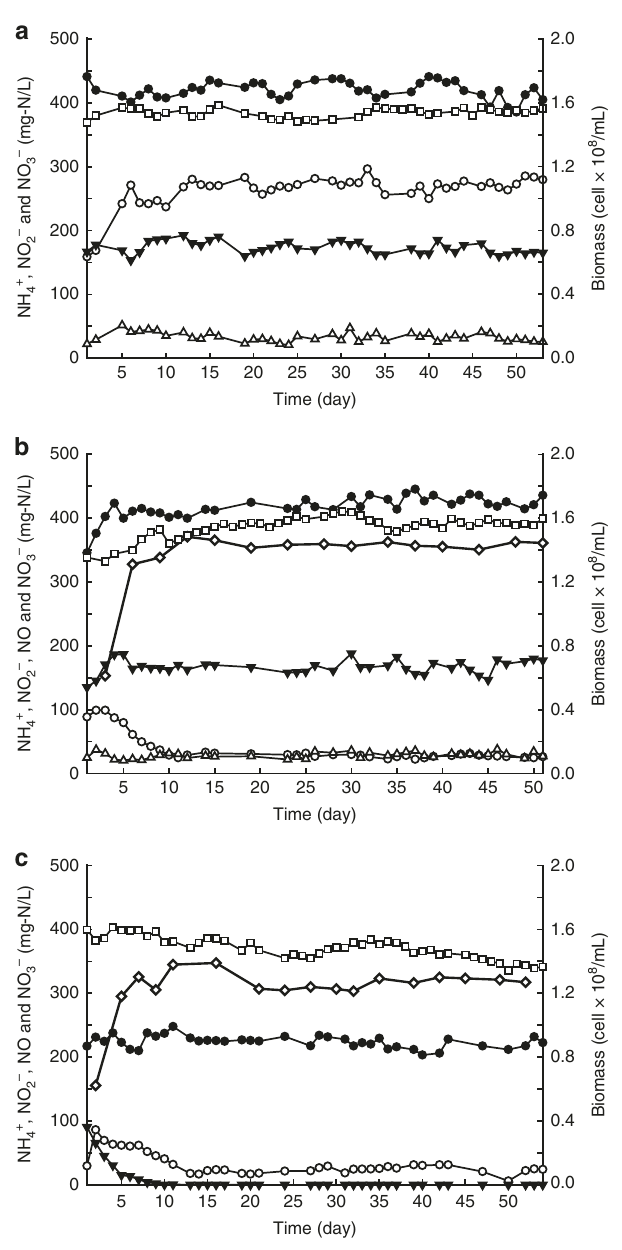
Fig. 1 Nitric oxide, nitrite, ammonium consumption, nitrate production, and biomass growth during reactor operation. ( a ) reactor I (control reactor, supplied with ammonium and nitrite), ( b ) reactor II (supplied with ammonium, nitrite, and NO) and ( c ) reactor III (supplied with ammonium and NO). Filled and empty circles indicate ammonium concentration in the in fl uent and ef fl uent, respectively. Empty triangles indicate nitrite concentration in the in fl uent. Nitrite concentration in the ef fl uent was always below detection limit. Filled triangles indicate nitrate concentration in the ef fl uent. Cell concentration is displayed by cell numbers per ml (open squares). Nitric oxide (empty diamonds) is displayed as consumption by the bioreactors. This is calcualted from the difference between concentration of nitric oxide in the in fl uent and ef fl uent of the gas phase of the bioreactor. The source data underlying this fi gure are provided as Source Data fi